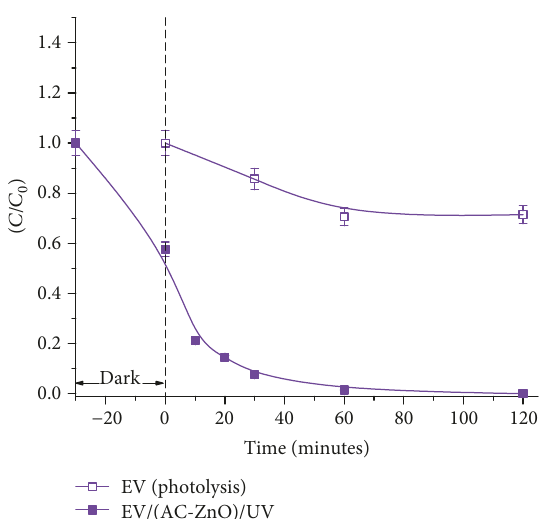
Figure 7: SEM image of the AC-ZnO material.